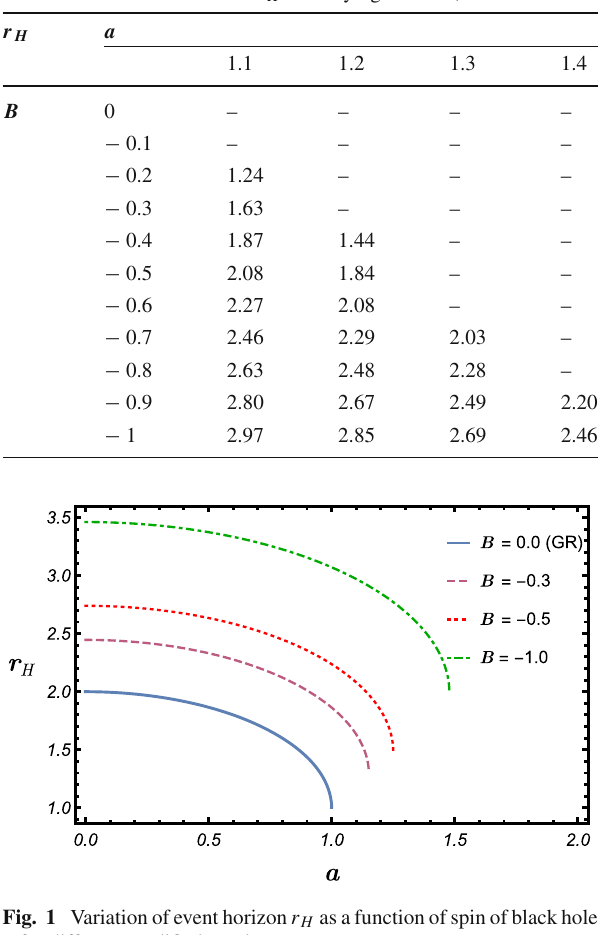
Table 2 Numerical values of r H for varying B and a , with a > 1